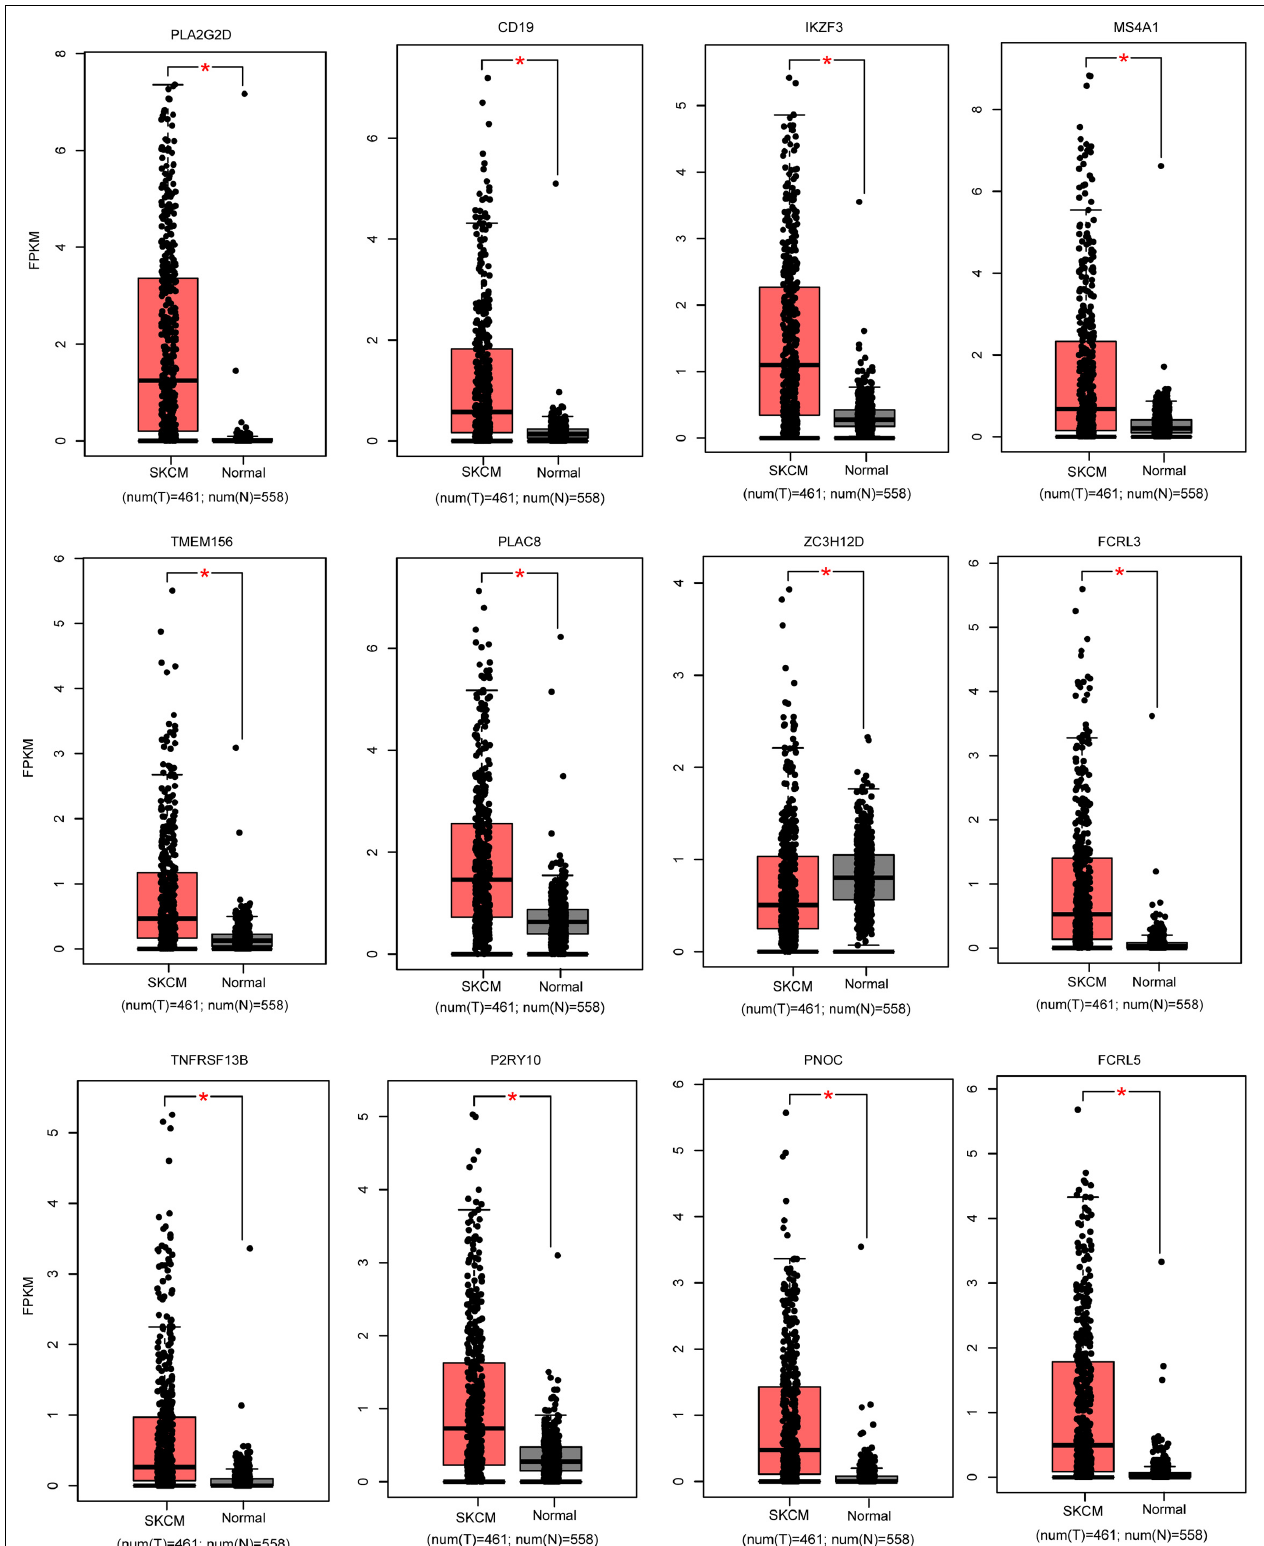
FIGURE 4 | Validation of the expression pattern of hub genes in melanoma. The red color represents the melanoma samples, while black indicates normal samples. * P < 0.05.